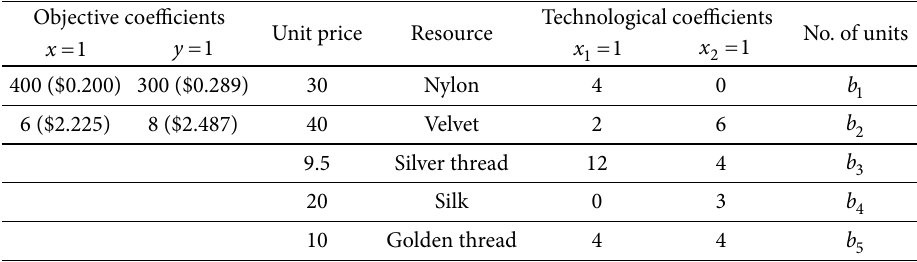
Table 4. Information table for Example 2 Objective coefficients Unit price Resource = 1 x = 1 y = 400 ($0.200) 300